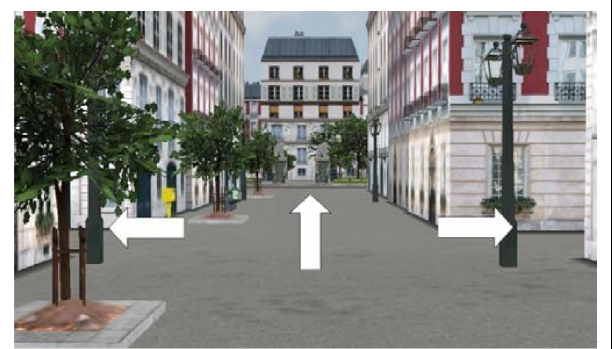
route was designed with two crossroads and two changes of direc- tion. The test route contained 14 crossroads, seven of which involved a change of direction ( Figure2 ). Participants watched the route as a pedestrian on a 15.4 inches computer screen (Fujistsu